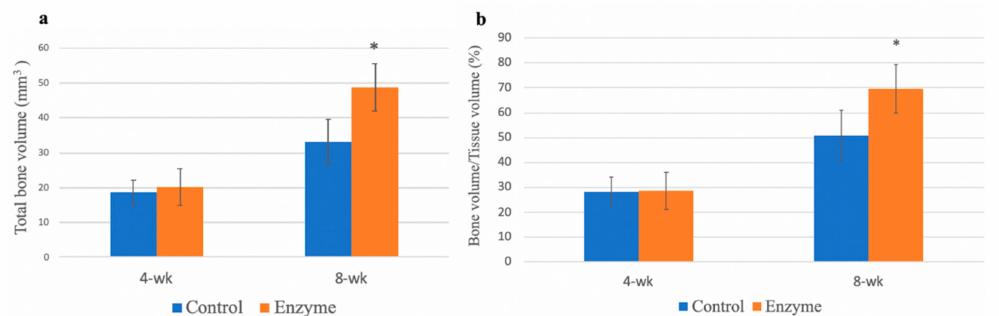
Figure 9. Micro-CT evaluation. Total bone volume (mm 3 ± SD) determined by micro-CT. The region of interest was measured following the long axis of the bone tunnel. ( a ) There was significantly more new bone formation at 8 weeks after collagenase treatment. Total bone volume / tissue volume was illustrated, and the ratio was significant 8 weeks after enzyme treatment. ( b ) p < 0.05, n = 6. The error bars designed the standard